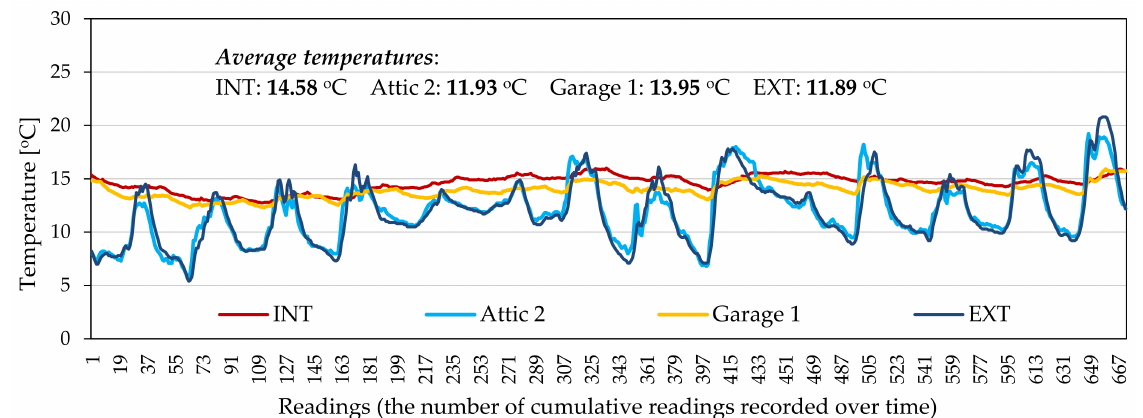
Figure 13. Global temperature profile in Attic 2 and Garage